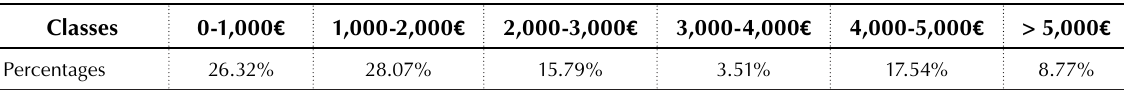
Table 3. Willingness to